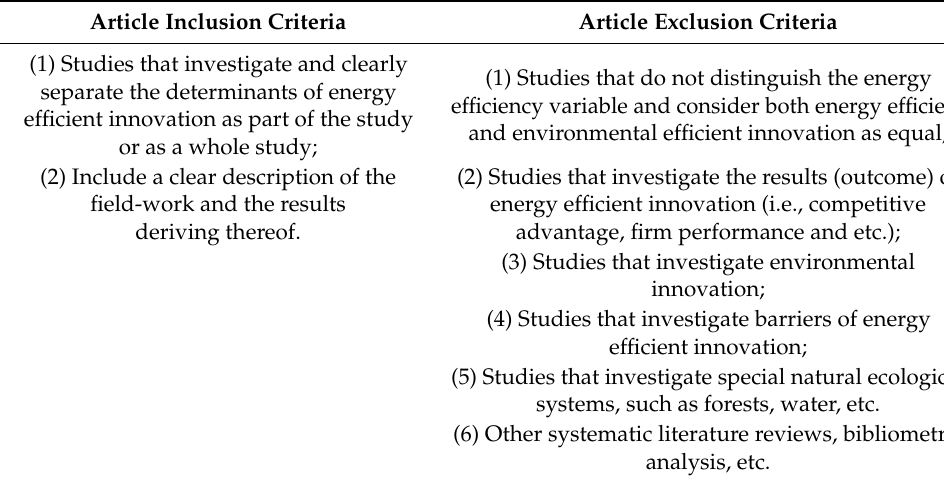
Table 2. Article inclusion and exclusion